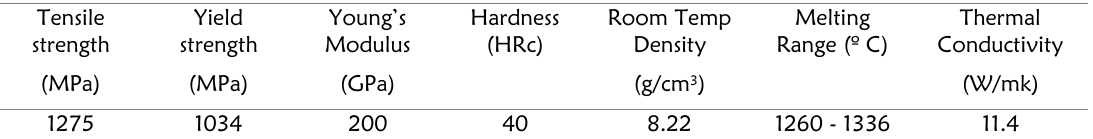
Table 1: Mechanical properties of Inconel 718 [17]